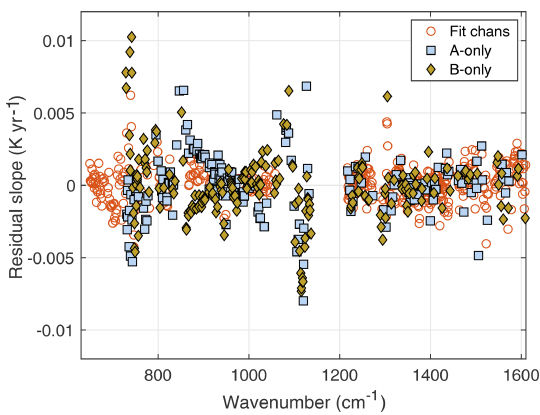
Figure 22. Anomaly fit residual time series for various combina- tions of 24 channels sensitive to N 2 O in the longwave. The bad N 2 O channels have easily visible jumps at times corresponding to AIRS hardware